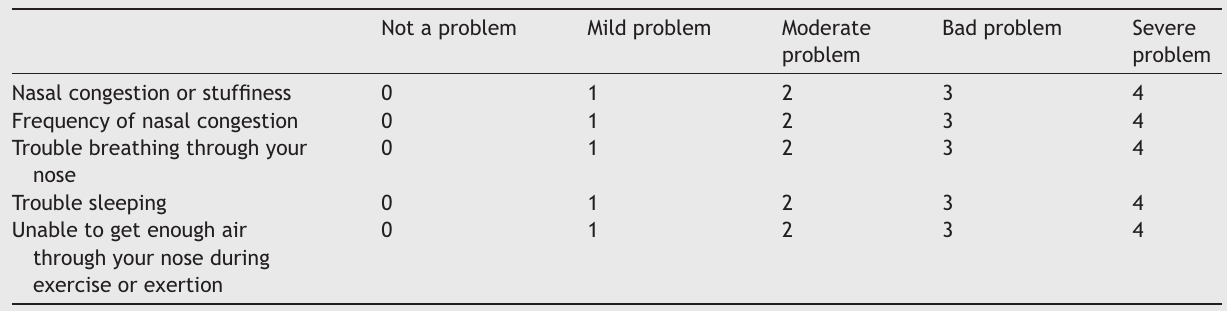
Nasal Obstruction Symptom Evaluation (NOSE)